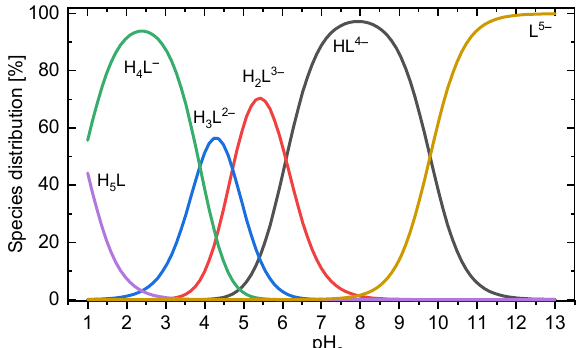
Figure 3. Species distribution diagram calculated for 1 mM of total PBTC based on the p K a values obtained in this work ( I m = 0.5 m NaCl, T = 25 °C).